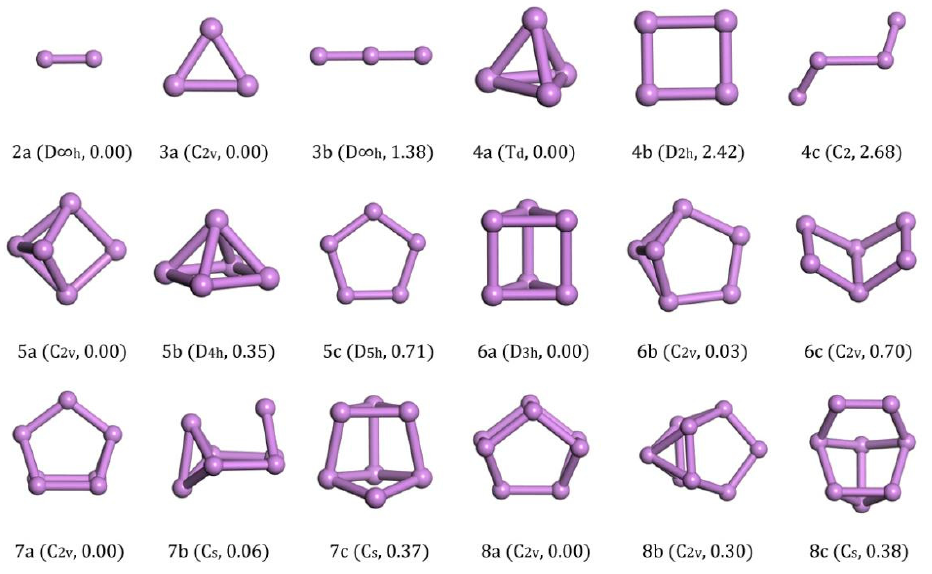
Figure 1. Lowest-energy and isomorphic structures for As n ( n = 2–8) clusters. The relative total energies are in eV.